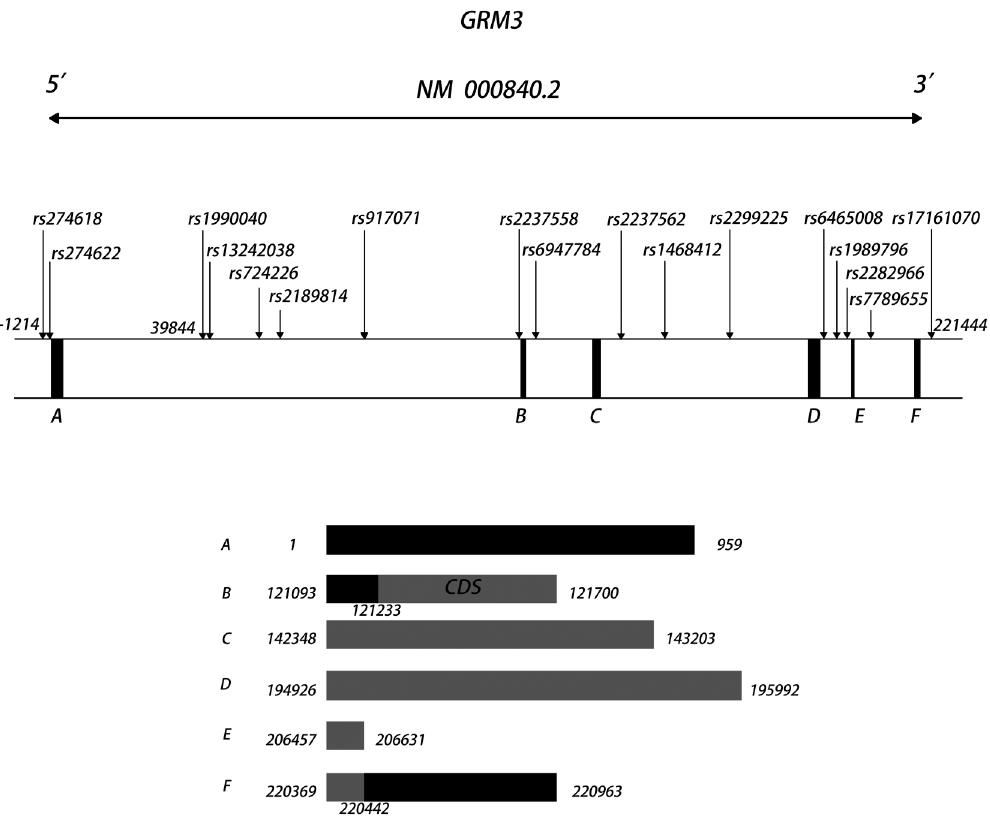
Figure 1. Gene structure of human GRM3 and the relative positions of the 17 SNPs used in our study. The schematic diagram of GRM3 gene is based on NCBI reference sequences NM 00084.2 and marks exons by the black bars orderly nominated A–F. The bands with serial number A– F below gene chart show the start and end position of corresponding exon in their left and right terminals. The black parts of these bands represent untranslated sequence, and the gray parts of these bands represent coding DNA sequence (CDS).